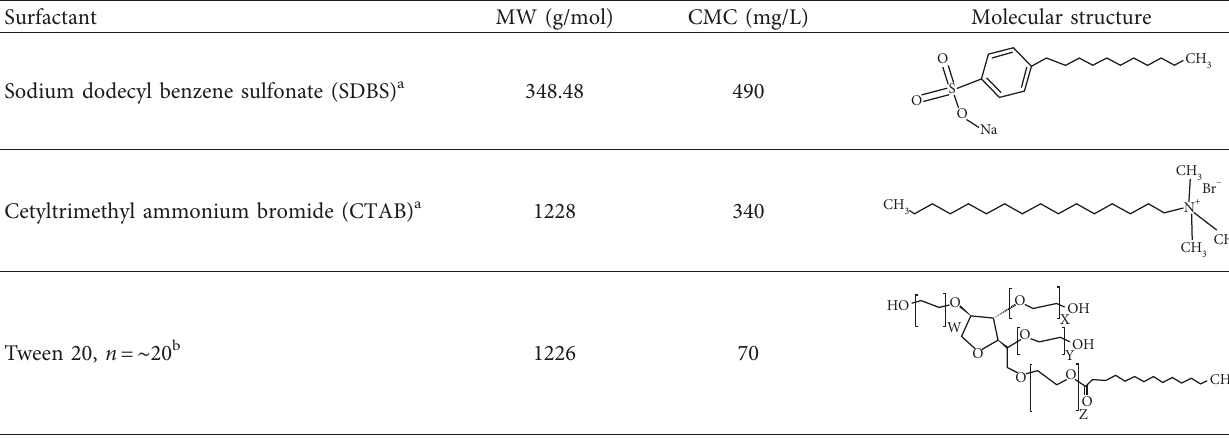
Table 2: Molecular weight (MW), critical micelle concentration (CMC), and molecular structure of the